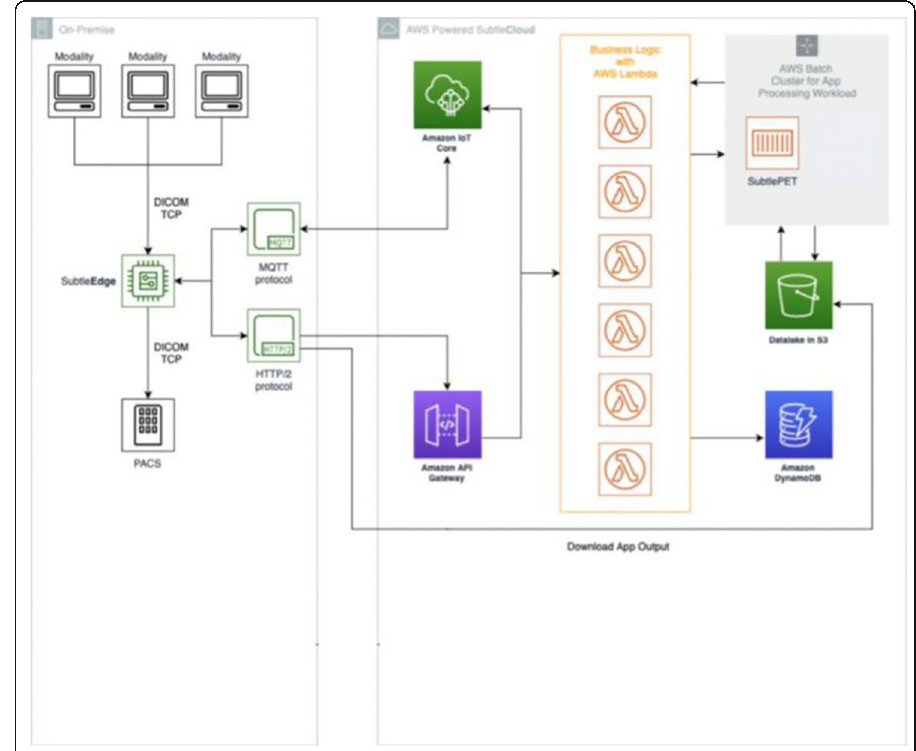
Fig. 2 Technical integration architecture and